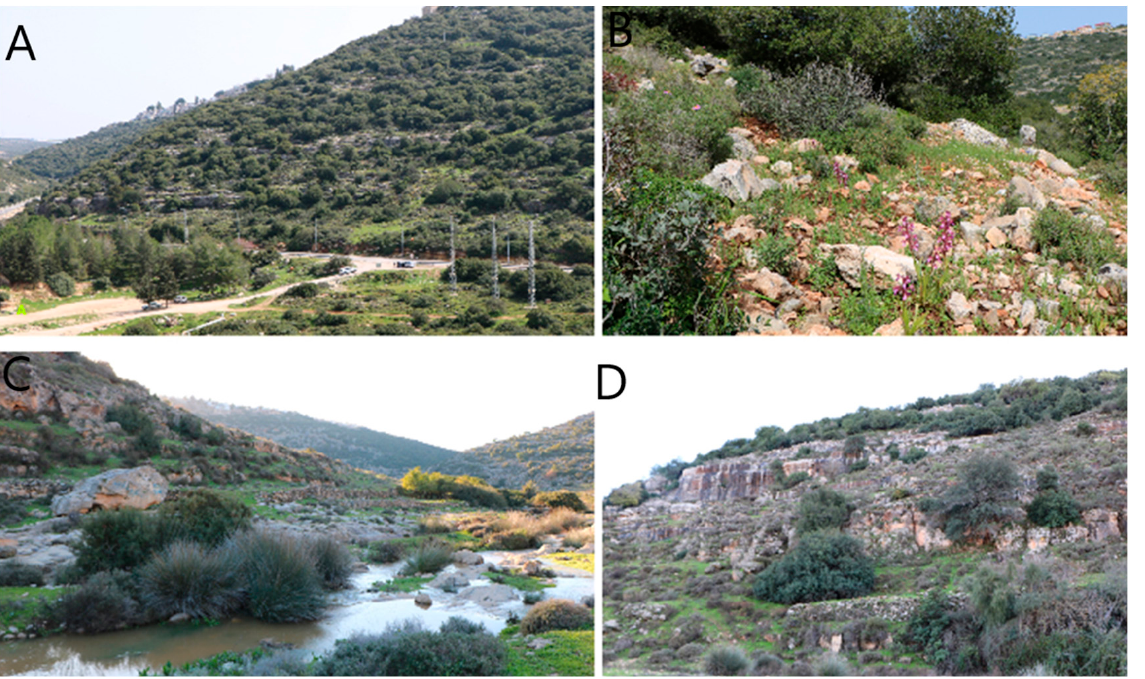
Figure 2. Floral habitats of Wadi Qana. ( A ): Entrance of the valley from the main road shows a hill with typical Mediterranean undisturbed oak forest and, below it, pine trees at the road intersection; ( B ): Batha and Garigue areas; ( C ): near one of the springs in the valley with Juncus and other hydrophilic plants; ( D ): cliff side with natural areas and olive cultivation in the valley.